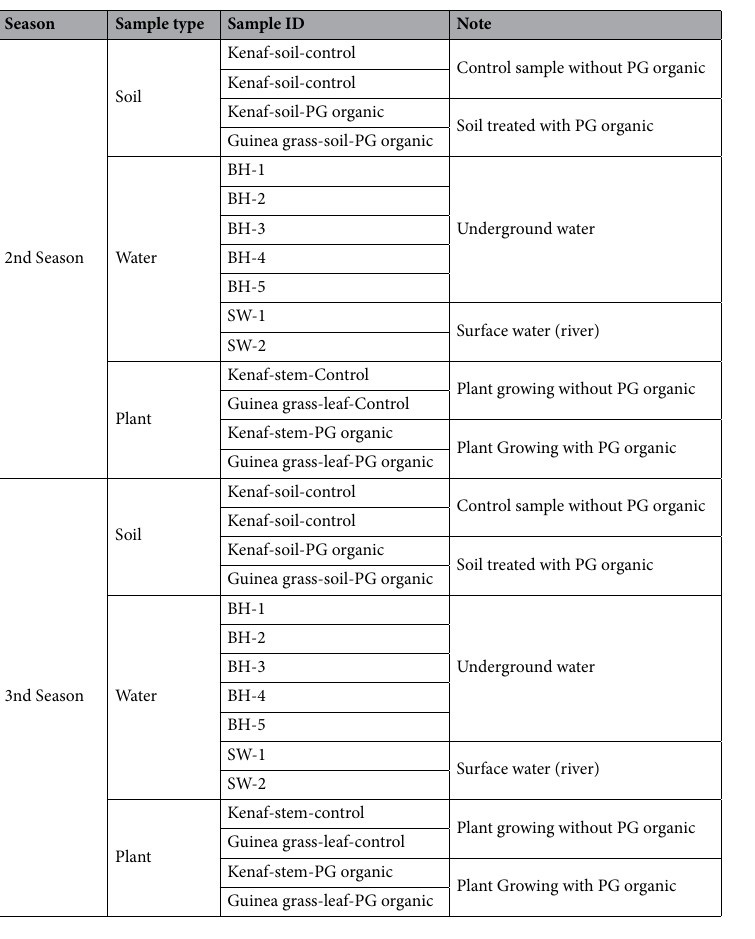
Table 1. Locations of soil, plant, and water sampling at the experimental